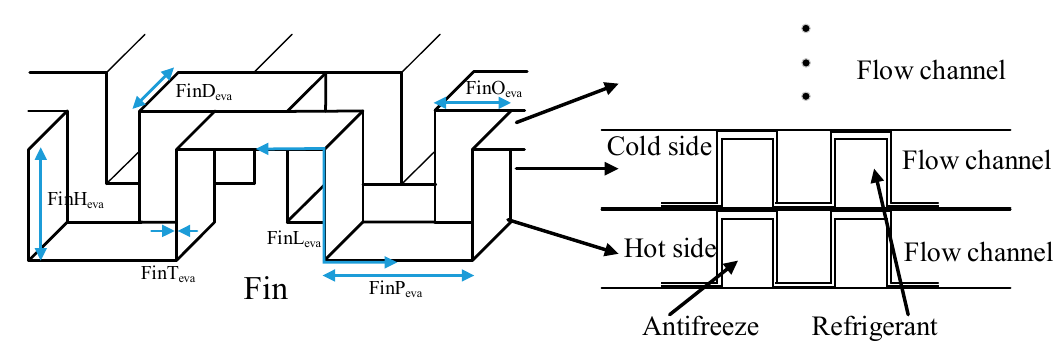
Figure 2. Structure of Antifreeze-R134a Heat Exchanger (ARHEx).